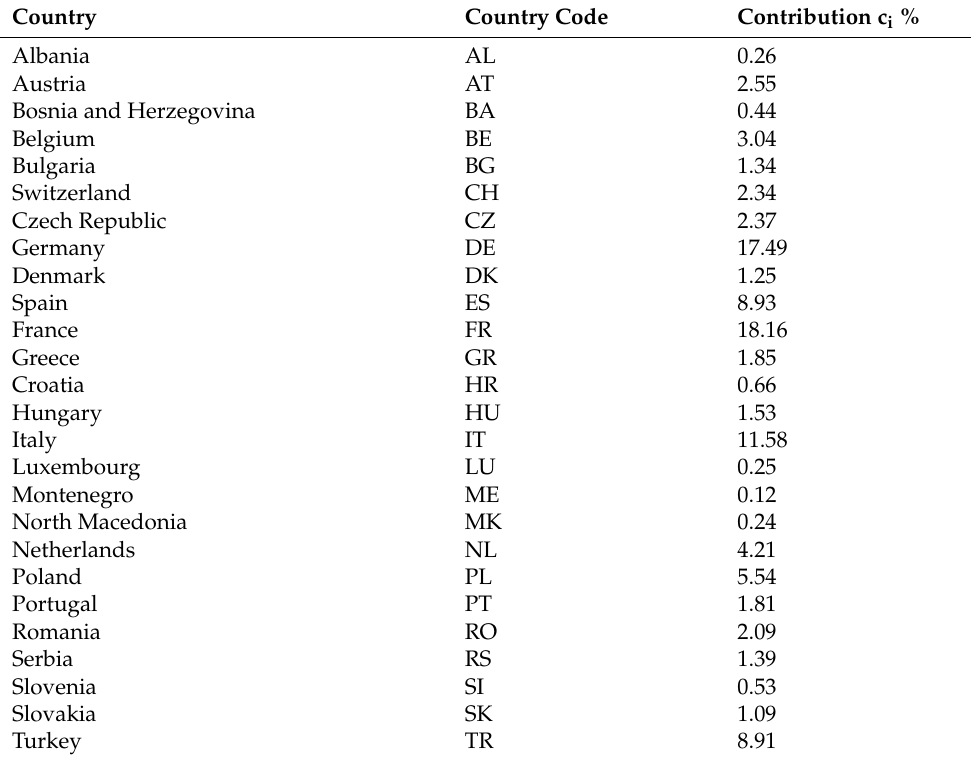
Table 2. Contribution coefficients in the CE synchronous area